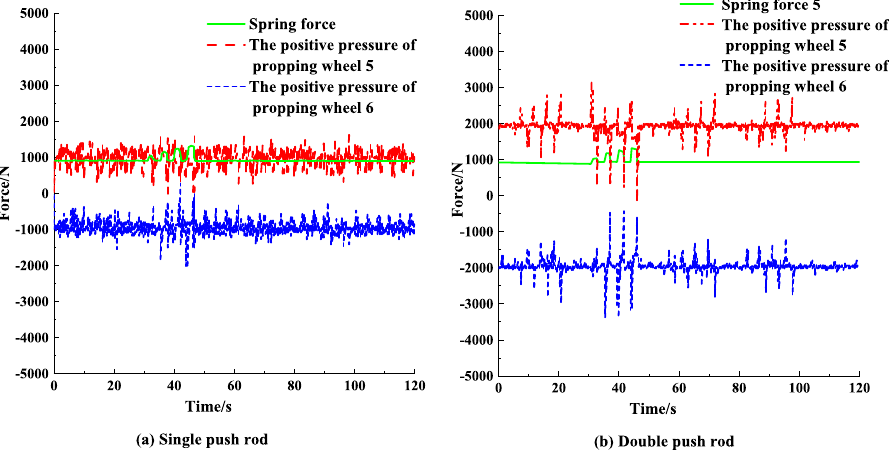
Figure 11. The change of positive pressure of single push rod support adjustment mechanism, double push rod − double spring support adjustment mechanism under the barrier of well wall